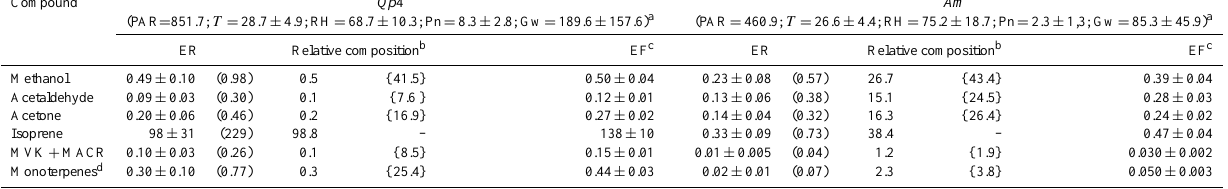
Table 1. BVOCs emitted by Q. pubescens ( Qp 4) and A. monspessulanum ( Am ) branches, 1 and 2 June respectively, measured with a PTR- MS. Daily mean ( n = 30) and maximum (parenthesis) BVOC branch emission rates (ERs) are in µgCg − 1 SD. Compound Qp